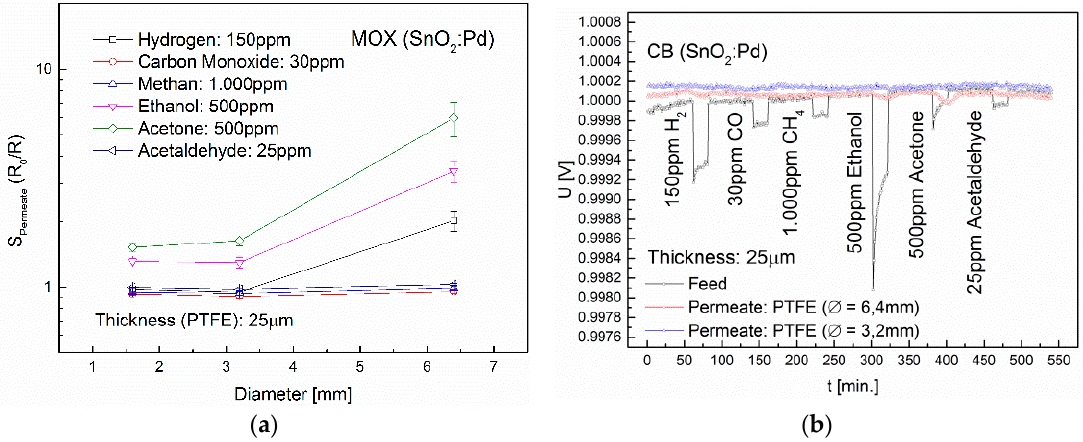
Figure 11. Influence of the diameter of a PTFE membrane on the diffusion of the gases H 2 , CO, CH 4 , ethanol, acetone and acetaldehyde. The membrane thickness is 25 µm. ( a ) Permeate signals of the MOX sensor; ( b ) Permeate signals of the CB sensor.